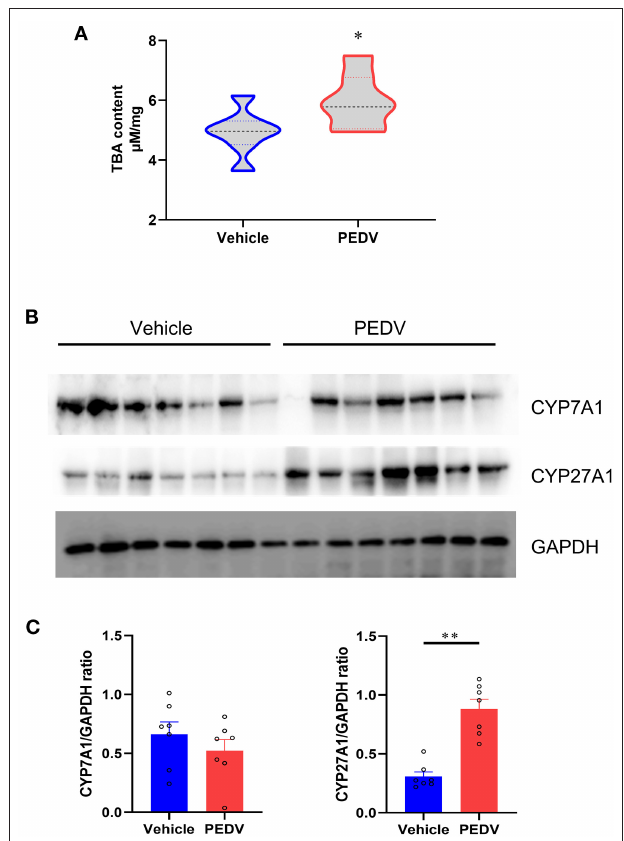
FIGURE 4 | Total bile acids (TBA) content and the expression of genes involved in cholesterol transformation were elevated in livers of PEDV-infected piglets. (A) TBA contents in the livers of piglets were analyzed and normalized to total protein concentrations. (B,C) Western blotting analysis was performed to evaluate the expression of Cholesterol-7a-hydroxylase (CYP7A1) and cholesterol-27a-hydroxylase (CYP27A1) at the protein level. Based on the intensity of protein bands, the relative expression levels of CYP7A1 and CYP27A1 were determined by normalization to GAPDH. The data are shown as the means ± SEM, n = 7, * P < 0.05, ** P < 0.01, using the two-tailed Student t